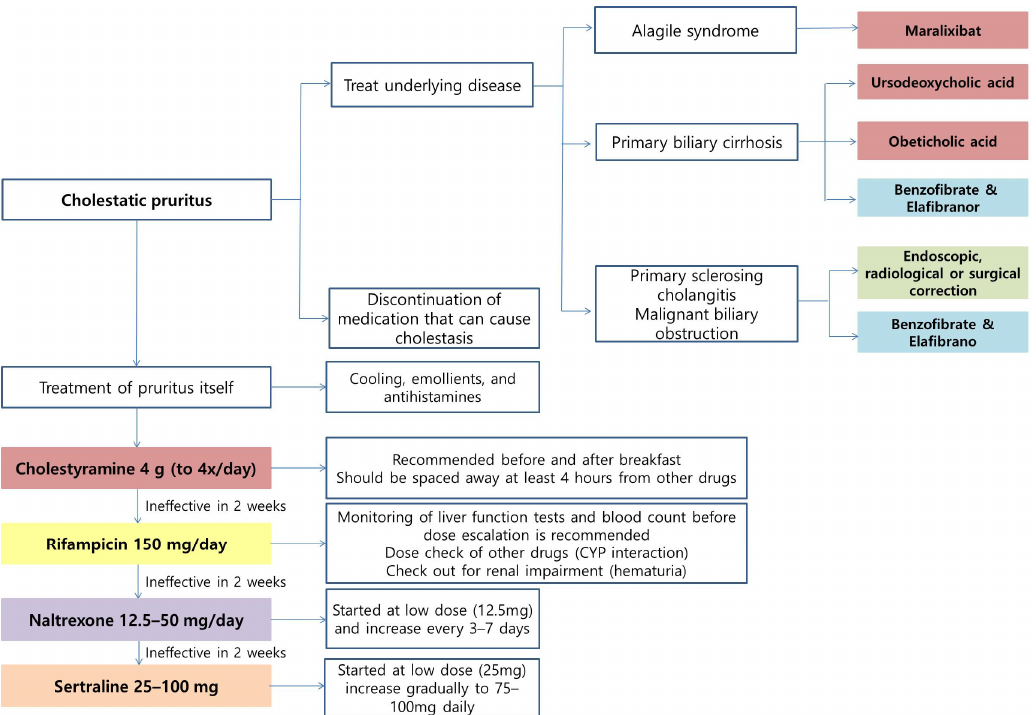
Figure 3. The treatment algorithm of cholestatic pruritus. Green: Treatment of bile duct obstruction; Red: inhibit bile acid synthesis or increase excretion (prevent reabsorption); Purple: opioid antagonist; Blue: improving overall liver function; Orange: regulation of neurotransmitters; Yellow: excretion and detoxification of pruritogens.